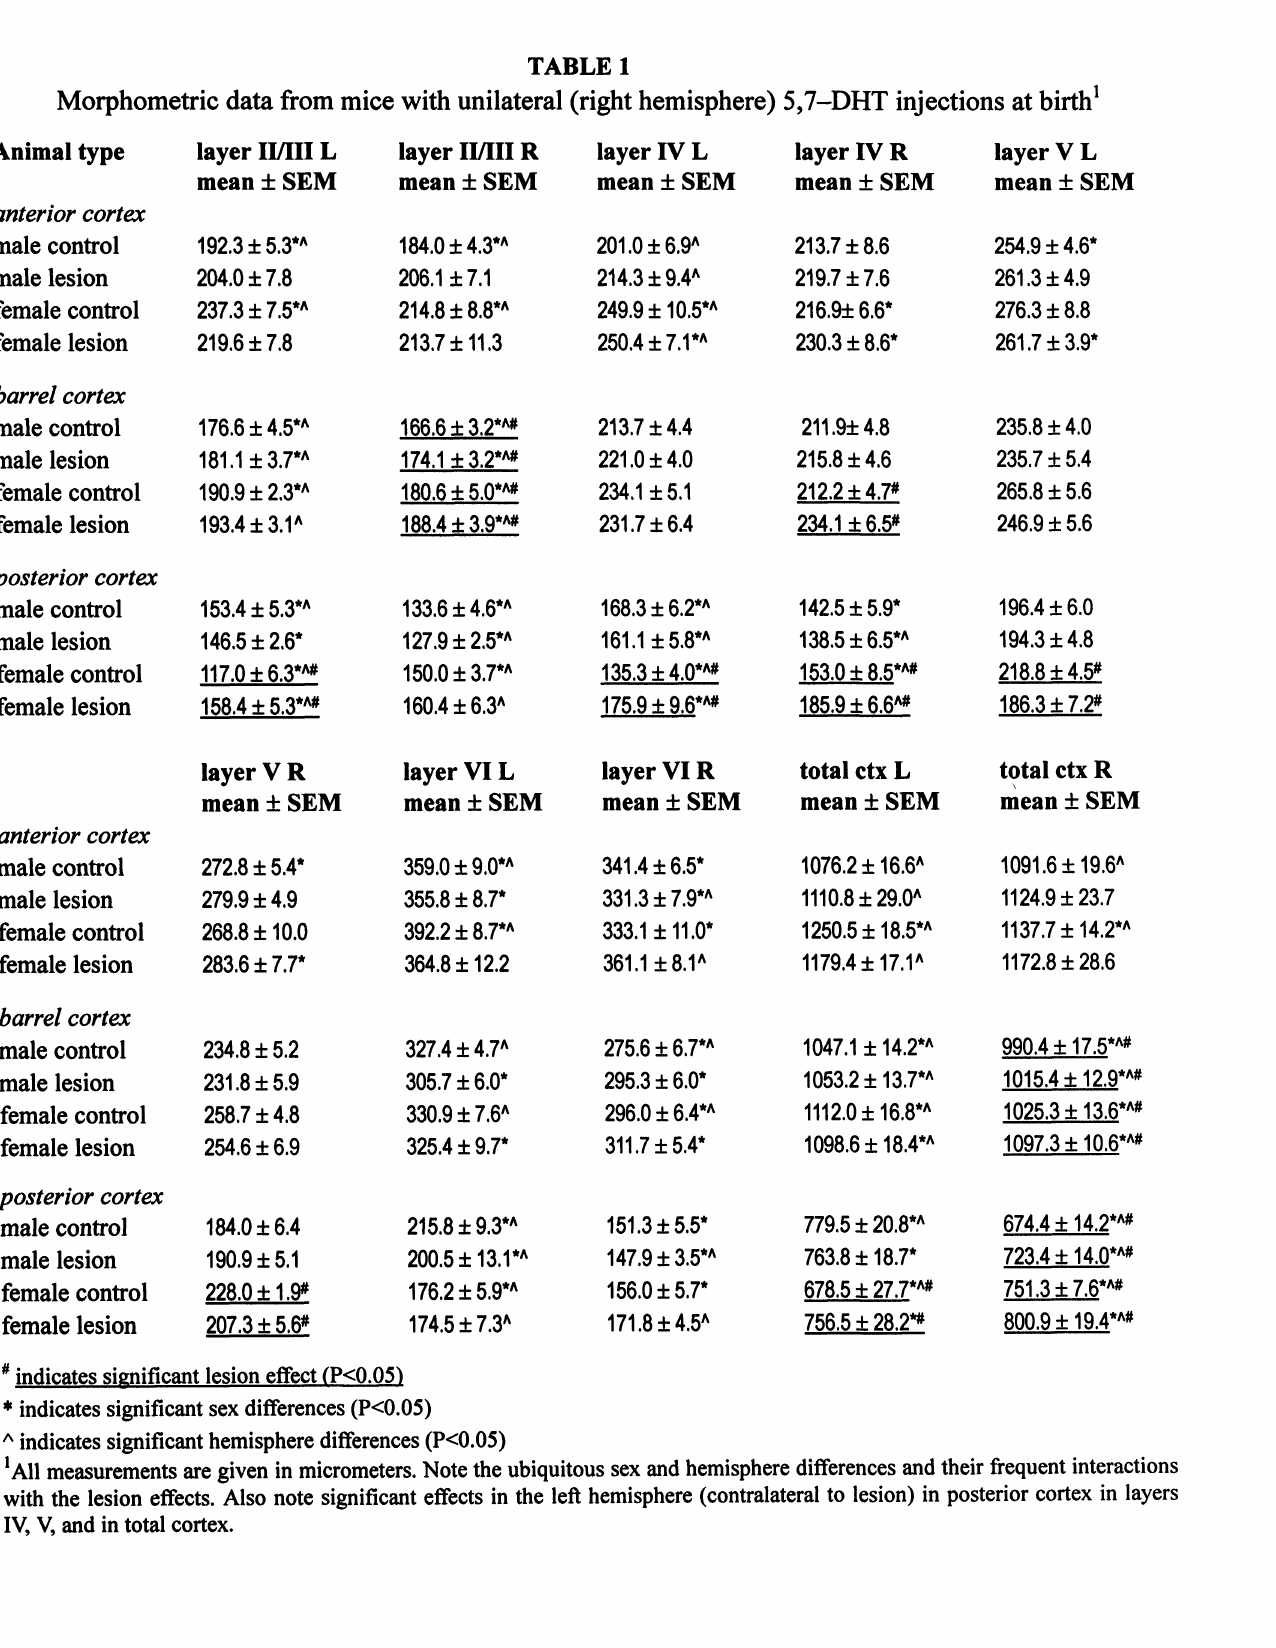
Morphometric data from mice with unilateral (right hemisphere) 5,7-DHT injections at